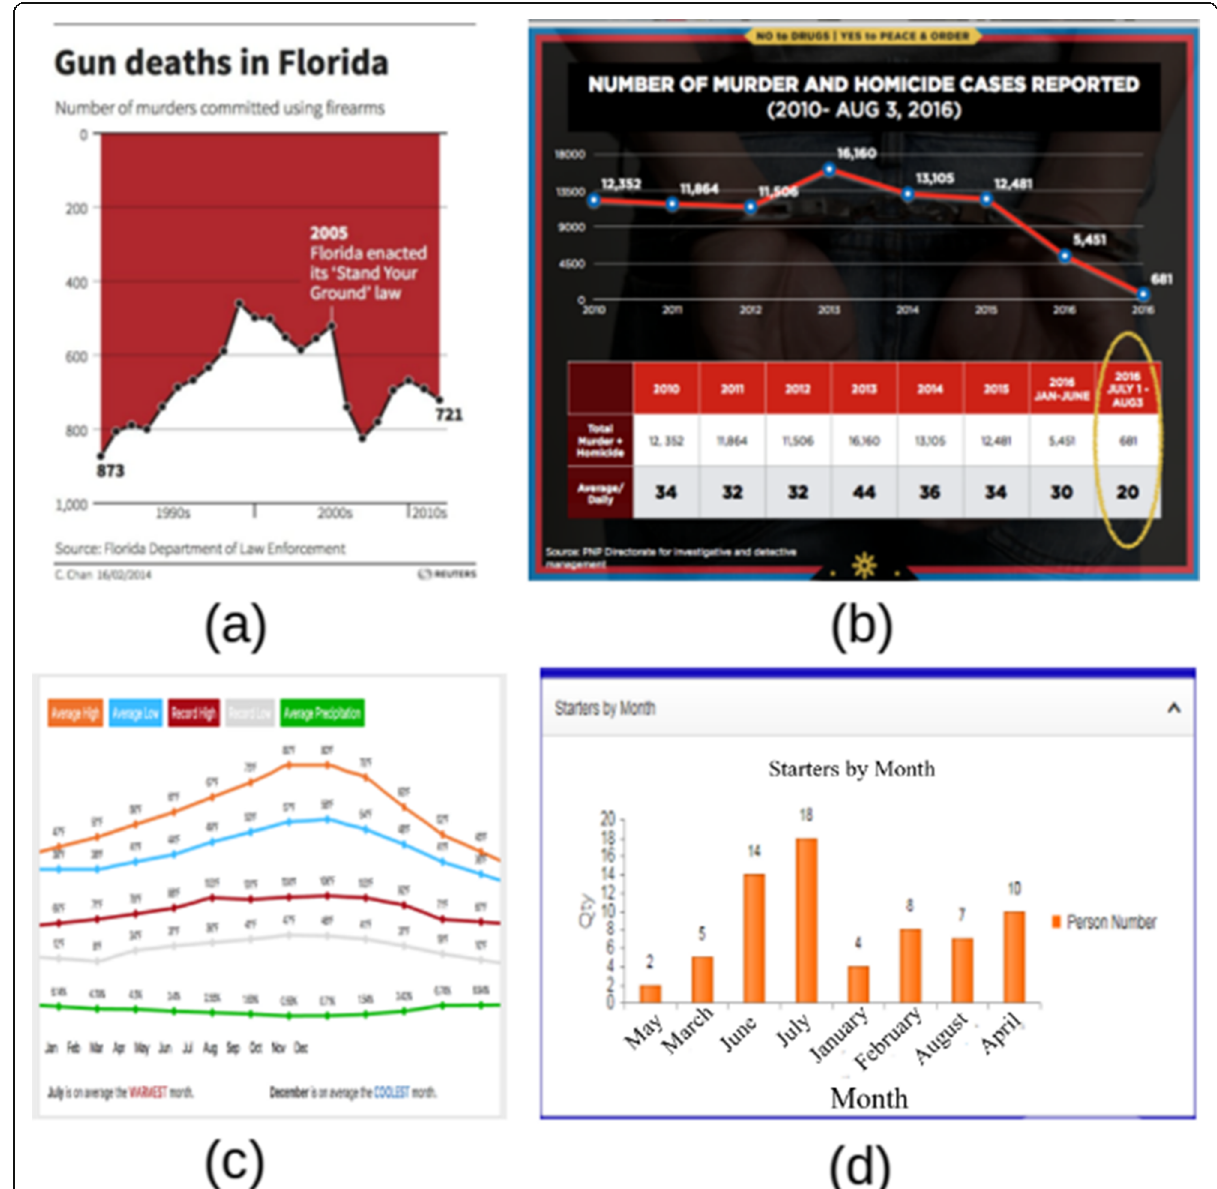
Fig. 9 Misinformation due to spatial and temporal violation [46]: a inverted axis, b data split out, c missing axis to line up data, and d mixing time